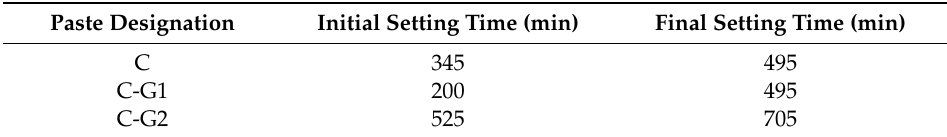
Table 5. Setting times of C, C-G1, and C-G2